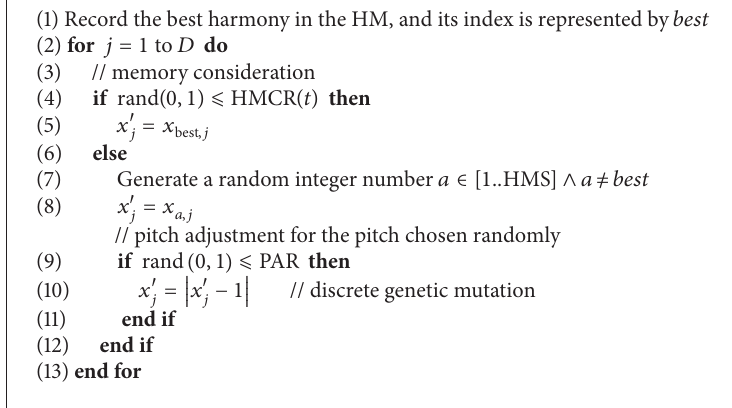
Algorithm 3: The procedure of improvising a new harmony of